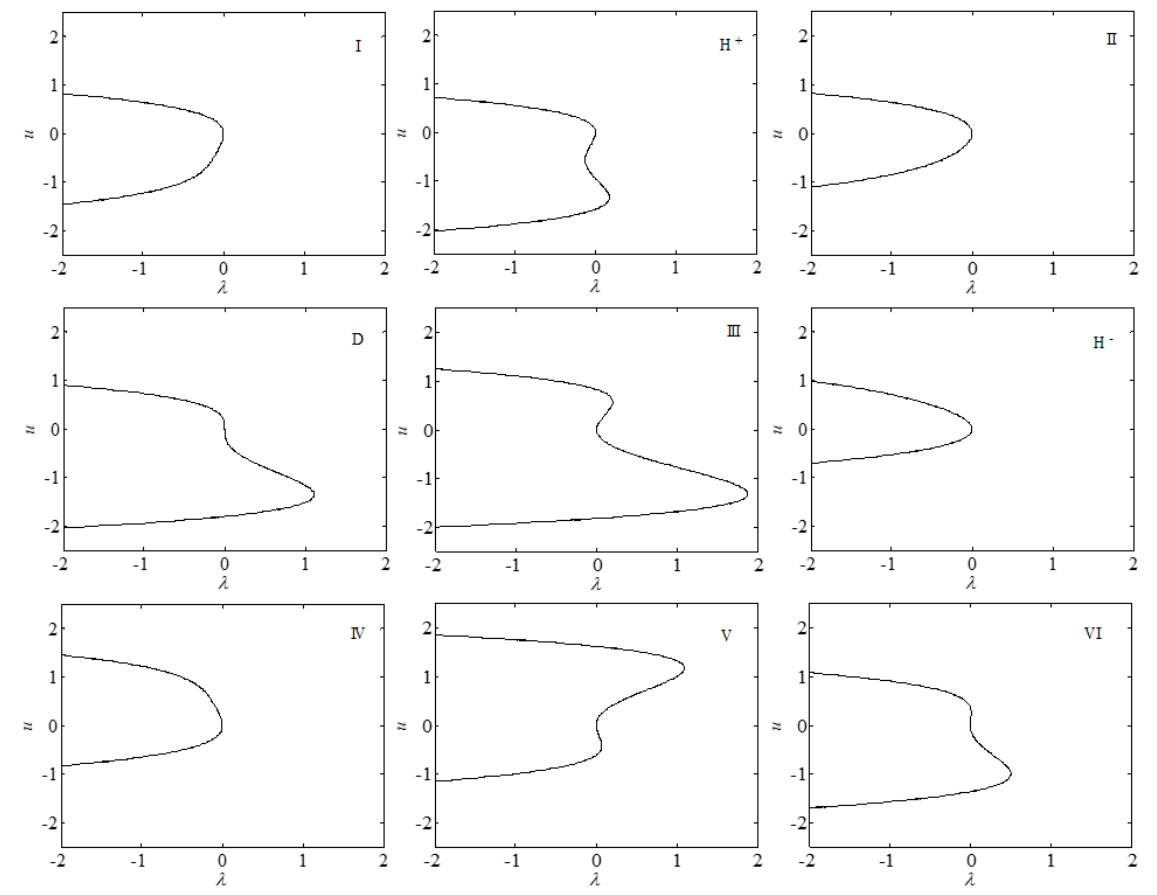
Figure 17. Topological structure of different regions in the transition set when d 1 = 0.